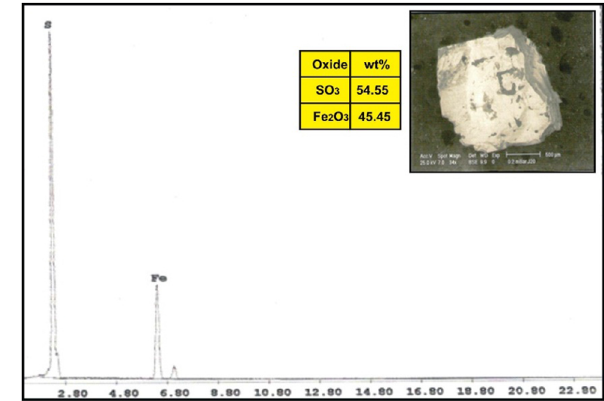
Figure 15: ESEM - EDX analysis of copper minerals in basalt dike at Wadi Geba.